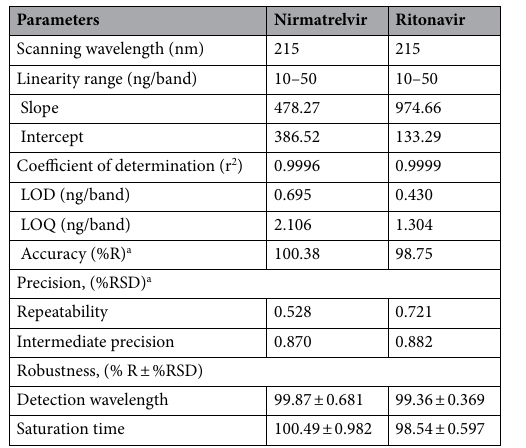
Table 1. Regression and validation results obtained for determination of nirmatrelvir and ritonavir by the described TLC densitometry method. a Values calculated for 9 samples (3 concentrations repeated 3 times).